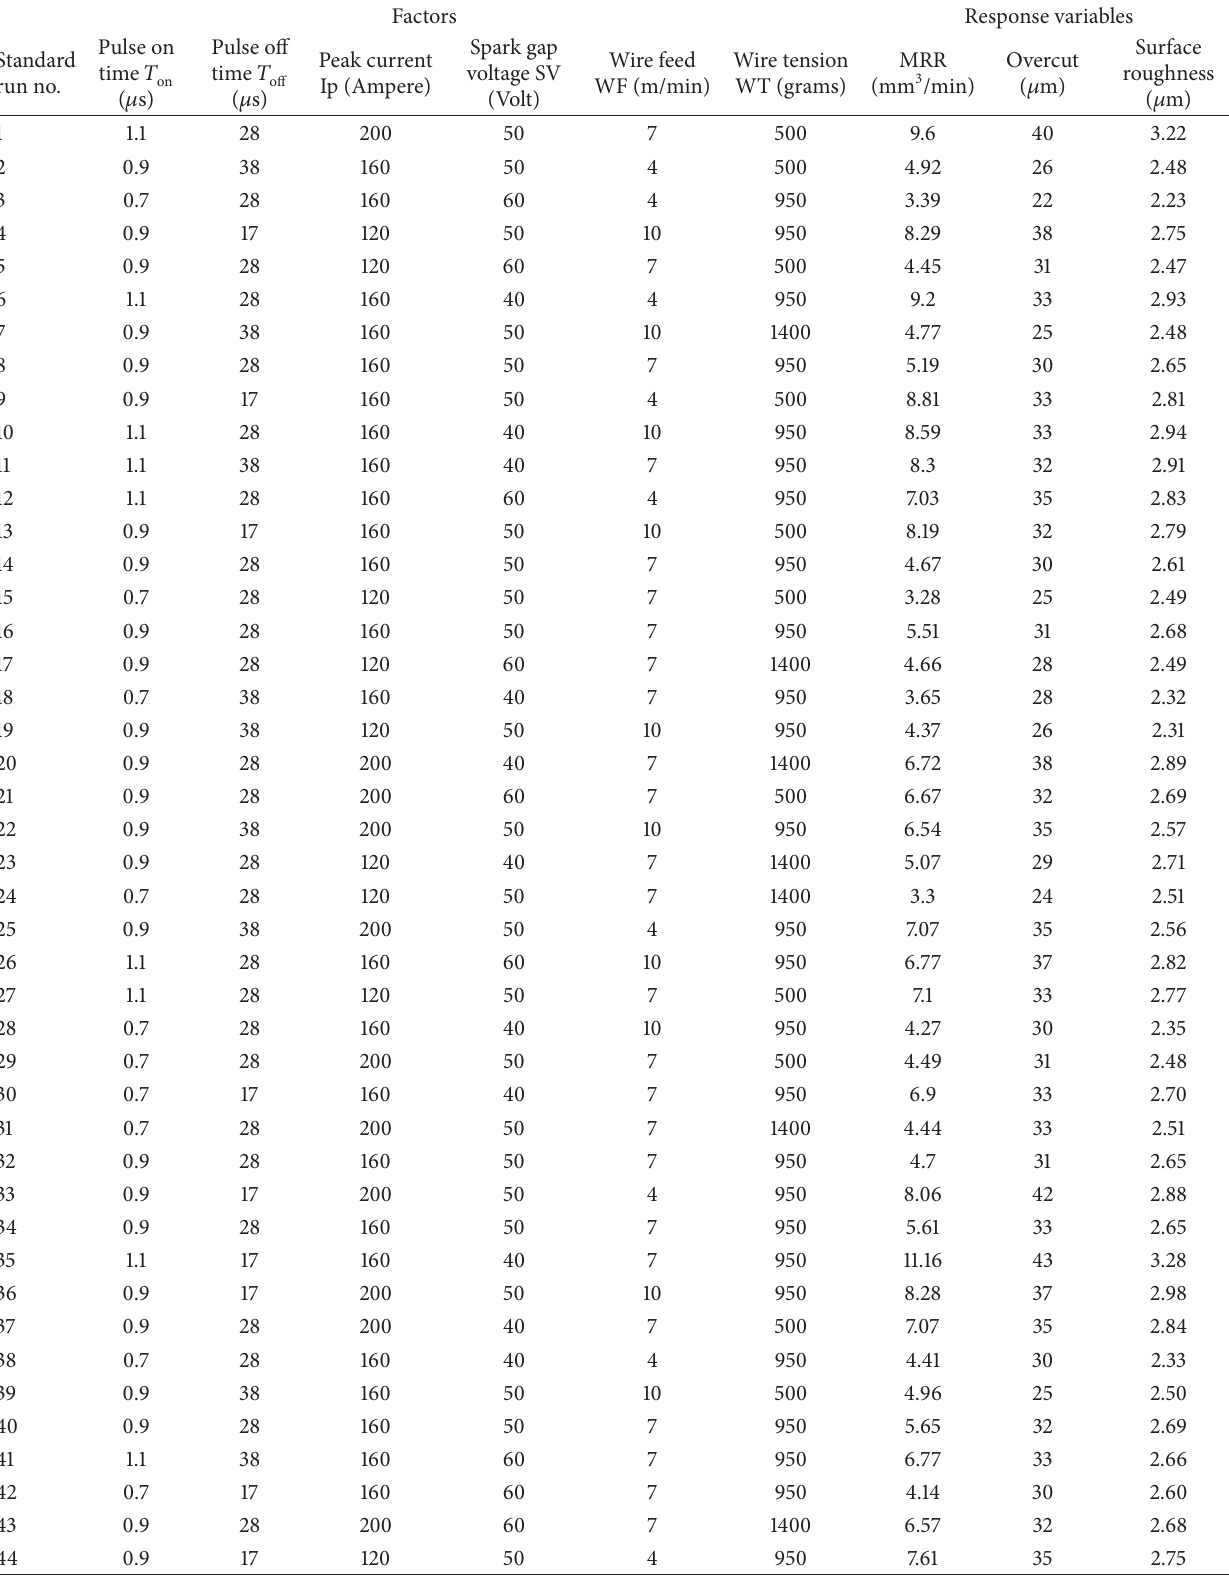
Table 2: Design of experiments matrix and results. Factors Response